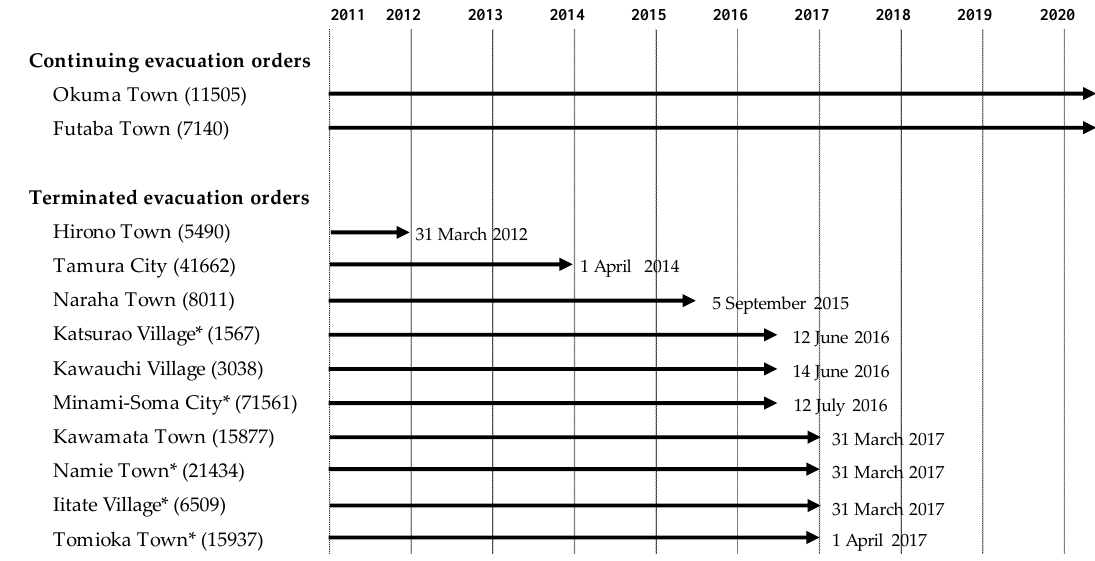
Figure 2. Continuing and lifting evacuation orders in each municipality in the evacuation area.